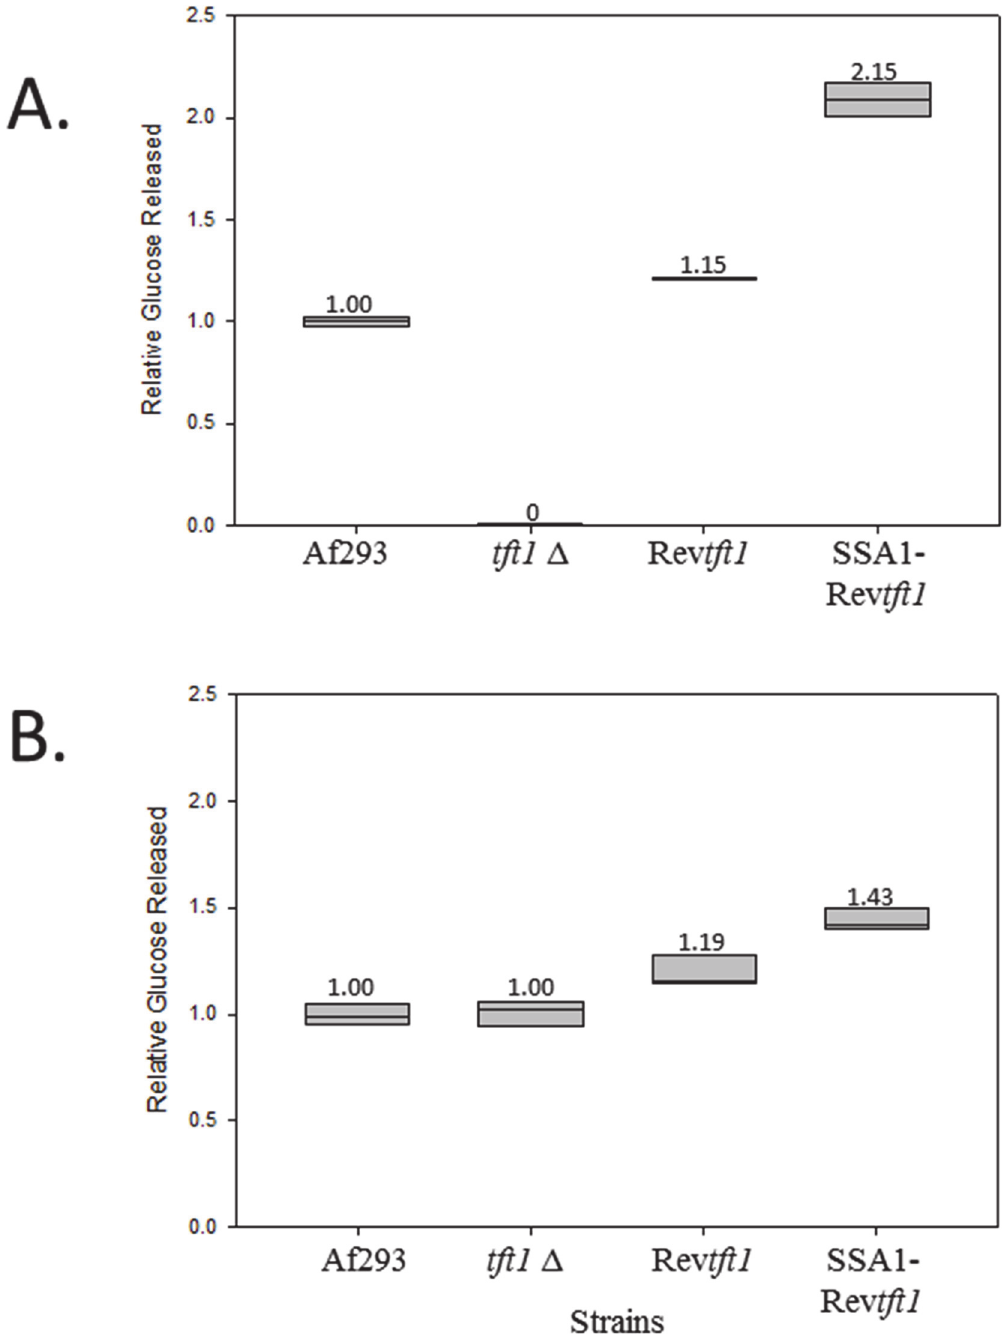
Fig 2. The relative glucose released when insoluble cell wall fractions were digested with A. endo β -1,3;1,4-glucanase or B. β -1,3 glucanase. tft1 Δ shown to release zero glucose when exposed to endo β -1,3;1,4-glucan hydrolase. The box represents calculated error based on replicates of 3 samples for each digestion. WT vs tft1 Δ , p < 0.001; WT vs Revtft1, p < 0.001; WT vs SSA1-Revtft1, p <